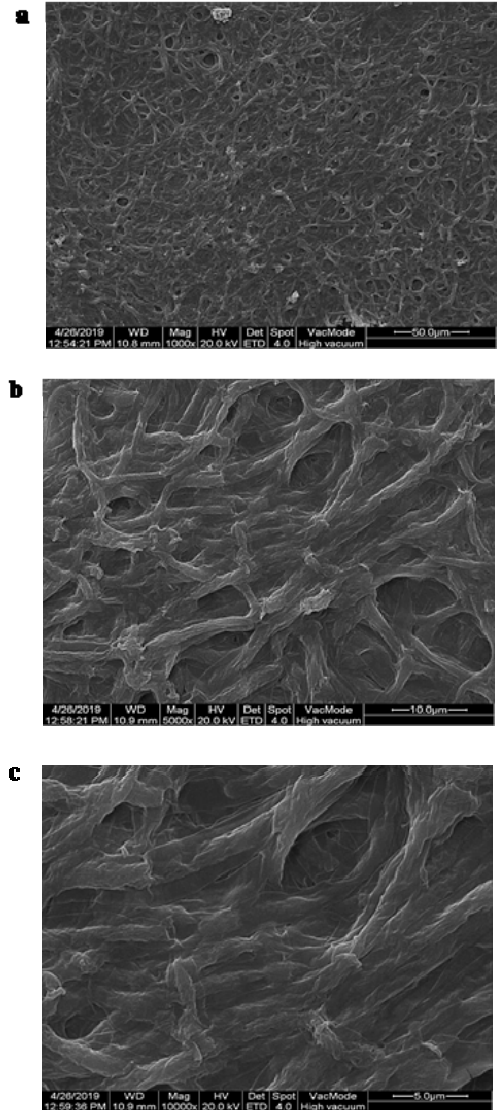
Figure 2. Field emission scanning electron microscope pictures of the cotton-like mycelium (with magnifications of ( a ): 1000×, ( b ): 5000×, ( c ): 10,000×).